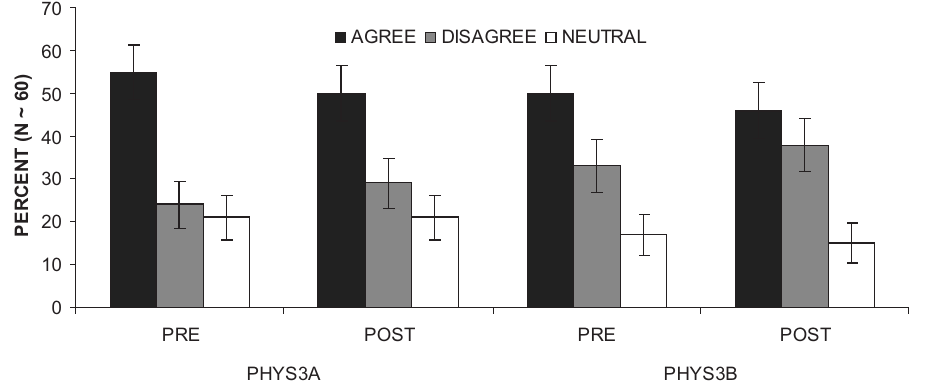
FIG. 7. Student responses to an attitudes statement on atomic electrons for each of the two mod- ern physics courses at pre- and postinstruction (cid:1) N (cid:5) 60 for each course and error bars represent the standard error on the proportion (cid:2) . See online supplement for addi- tional data from multiple semesters.